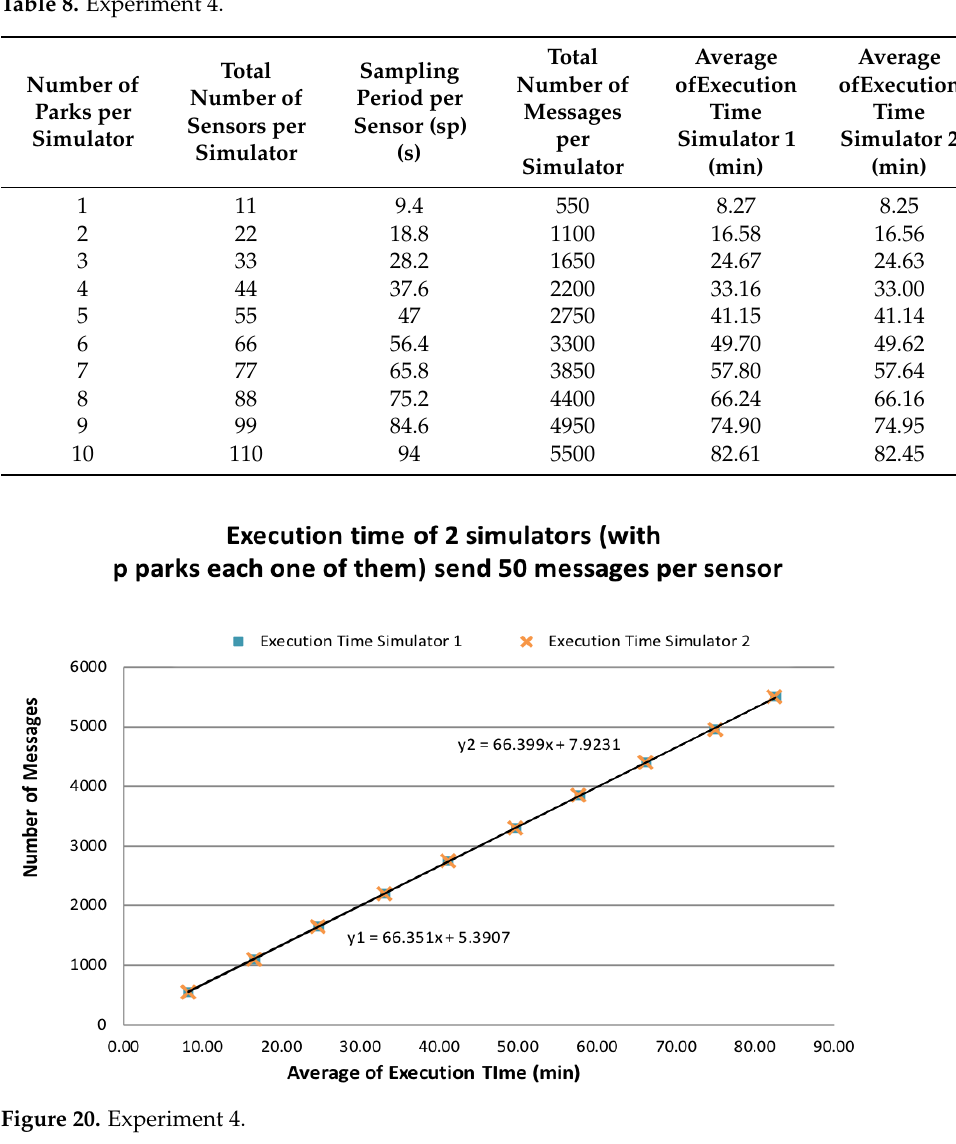
Figure 20. Experiment 4.